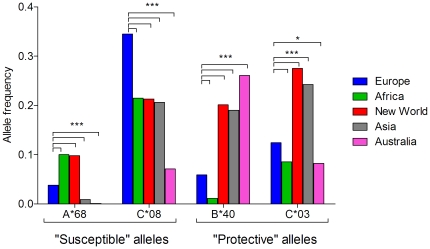
“Susceptible” and “protective” allele frequencies in world populations.The histogram displays the allele frequency of each “susceptible” and “protective” allele in various world populations. The North and sub-Saharan Africa were regrouped under Africa, North and South America were regrouped under New World, and Oceania, northwest, southeast, and southwest Asia were regrouped under Asia, Australia represents aboriginal populations only. *** P<0.0001 and * P<0.05 for Europe vs. comparison population.